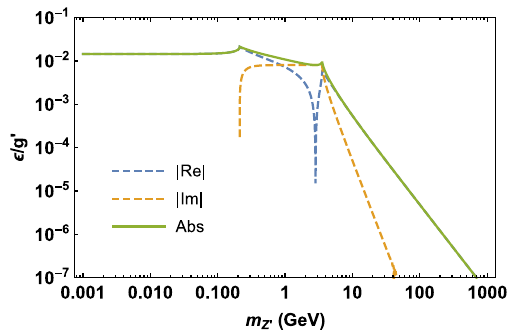
Fig. 1 Loop induced kinetic mixing normalized by g (cid:2) in L μ − L τ model. The blue and orange dashed curves represent the absolute value ) , and the green solid one of the real and imaginary part of (cid:8)( q 2 = m 2 Z (cid:2) is the absolute value of (cid:8)( q 2 = m 2 Z (cid:2)